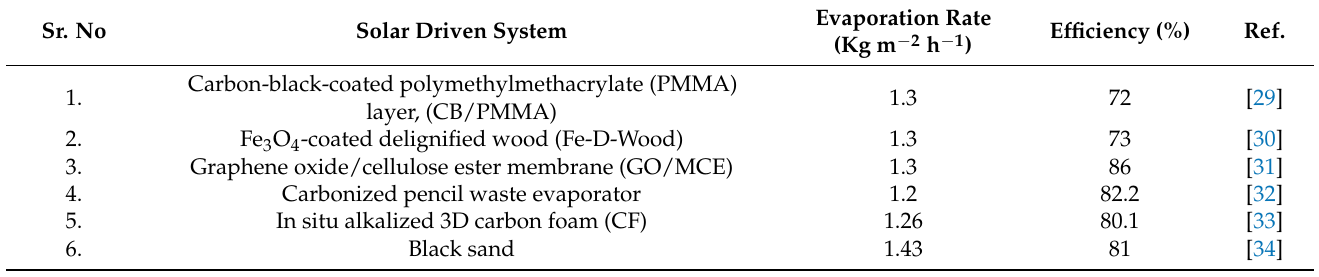
Comparison of solar-driven evaporation performance of SrCoO 3 @NF with other solar evaporators.